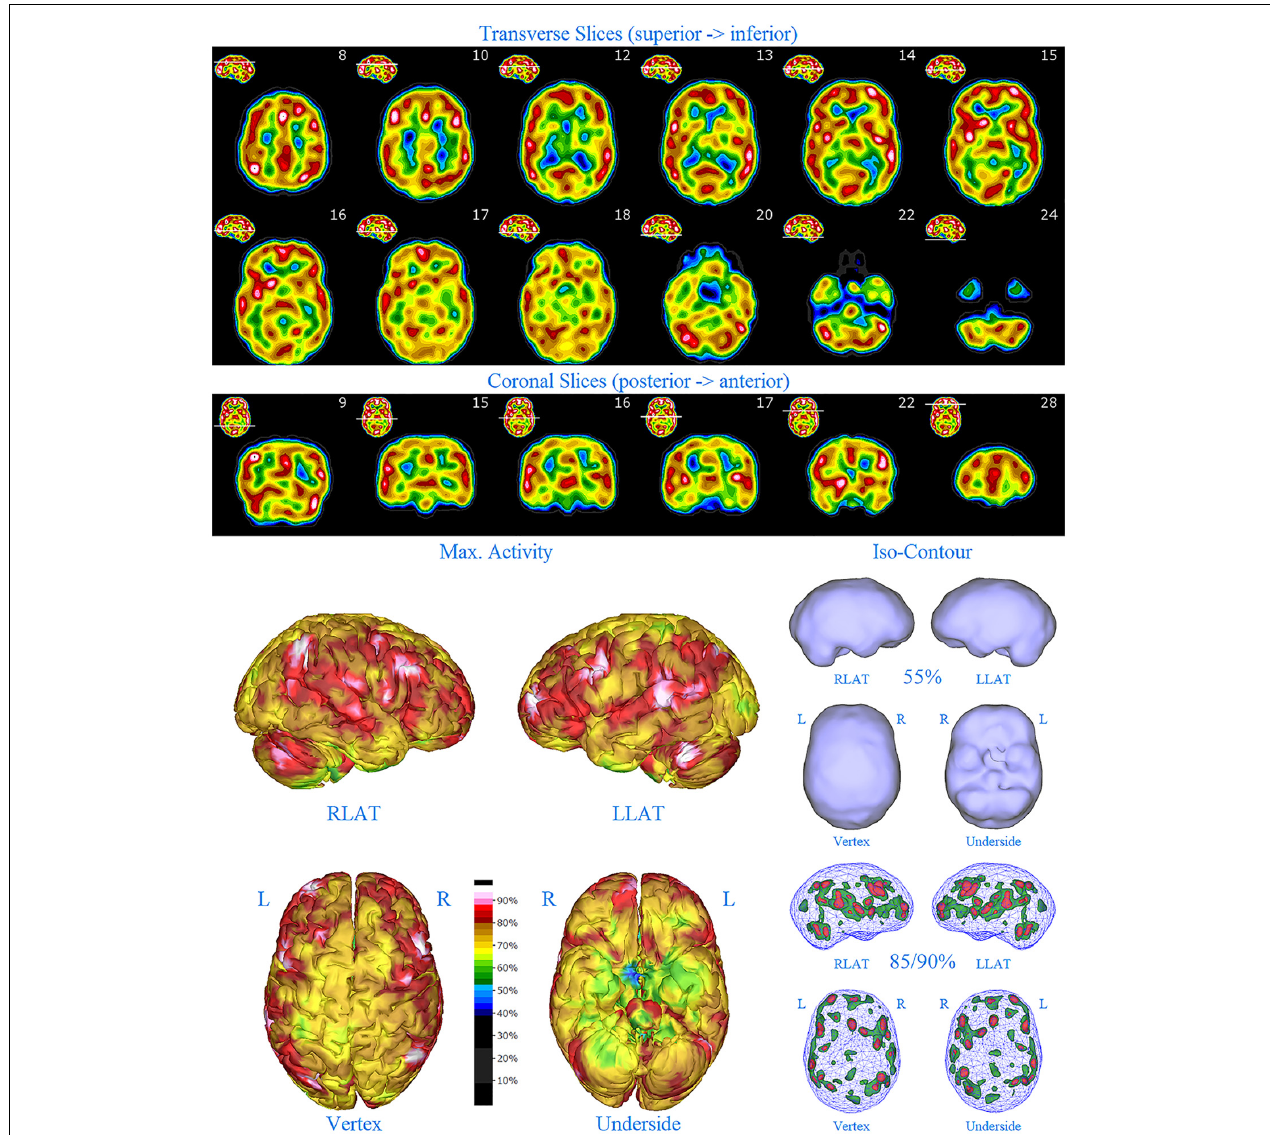
FIGURE 4 | First perfusion SPECT scan of Patient C. Arrangement, color scales, and views are identical to Figure 1 . Anatomical structures such as the thalamus are positioned similarly to the scan shown in Figure 2 . Labeling was eliminated to avoid obscuring the scan details. Perfusion of the thalamus is essentially symmetrical. Perfusion is markedly increased in the right caudate. Multiple cortical areas of markedly increased perfusion are evident. For example, the highest signal is found in the right posterior parietal cortex (white area with black central dot in horizontal